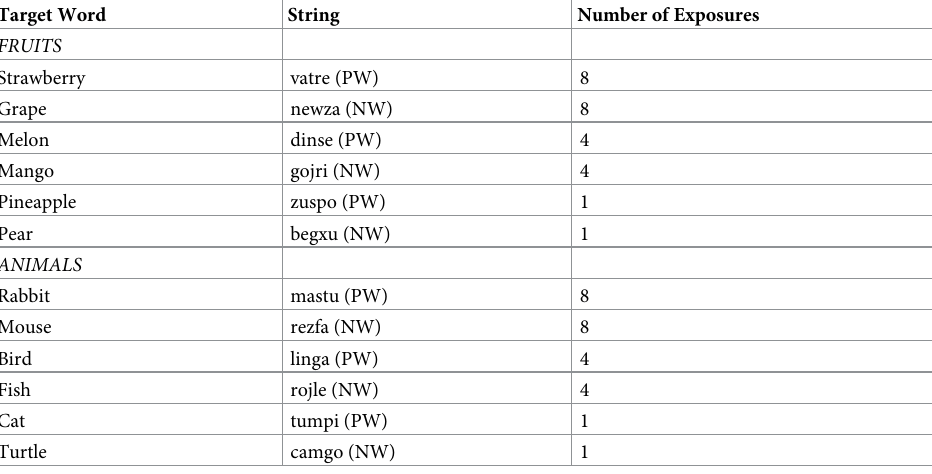
Table 1. Target words paired with a nonword (NW) or pseudoword (PW)